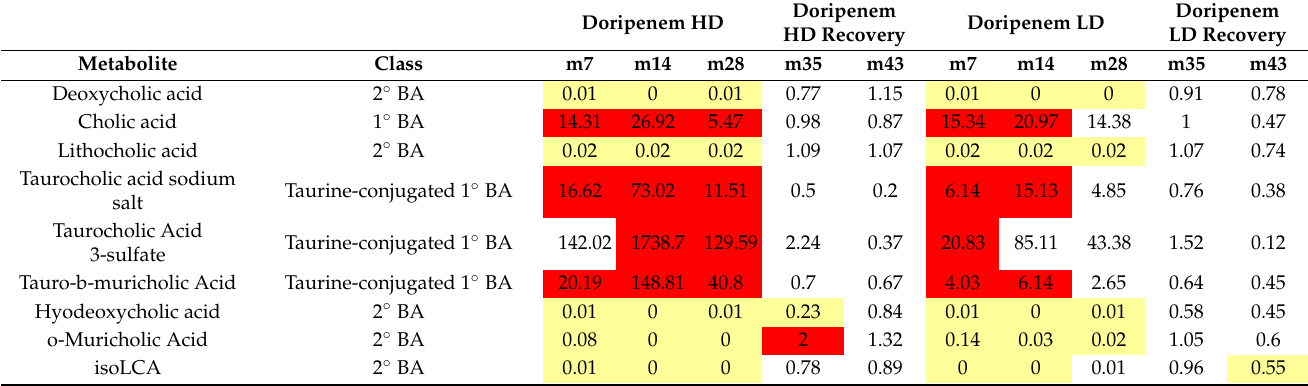
Table 5. Doripenem-induced BA fold changes in feces of male Wistar rats (N = 5 per group) dosed with 100 (LD) and 1000 (HD) mg/kg bw/day observed on days 7, 14, 28 (m7, m14 and m28) and on days 35 and 42 (m35 and m43) for the doripenem-recovery group. Statistically significant changes (Welch t -test; p -value < 0.05) are shown where red boxes mean an increase, yellow boxes mean a significant decrease, and white boxes indicate an insignificant change in the respective fecal